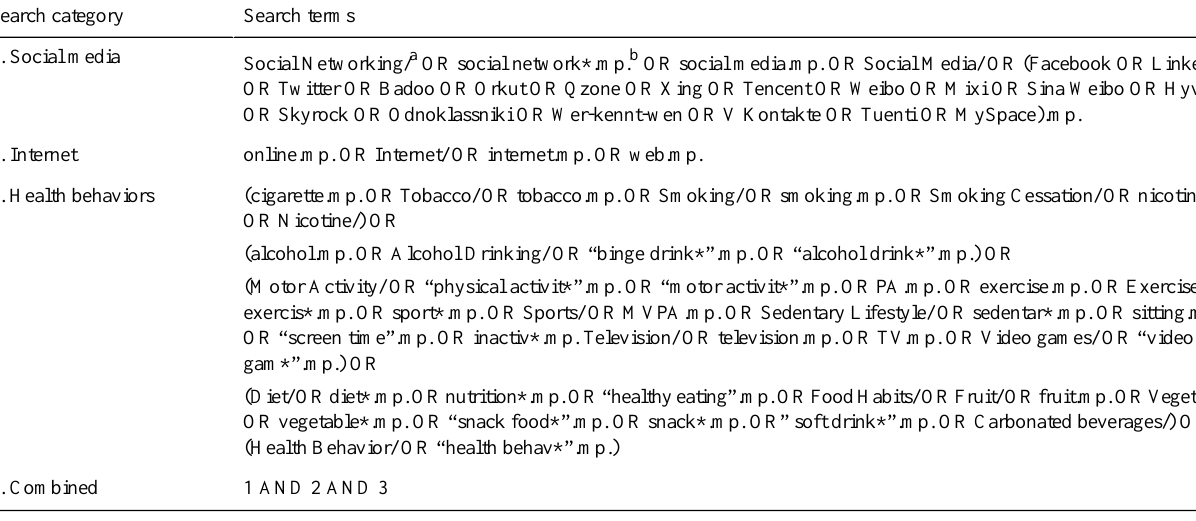
Table 1. The search strategy as used in Medline.